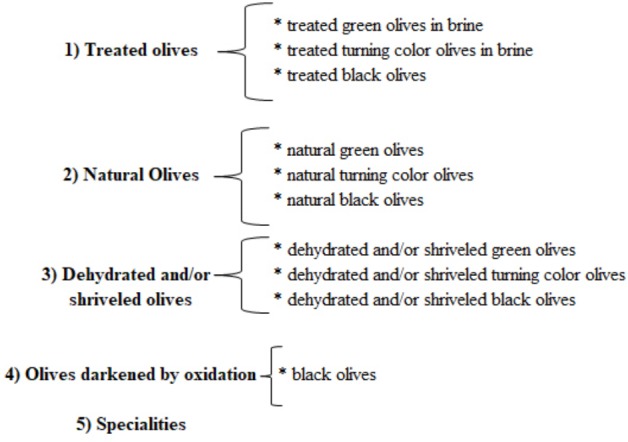
Table olives sorted regarding standard trade preparations (International Olive Oil Council [IOOC], 2004).